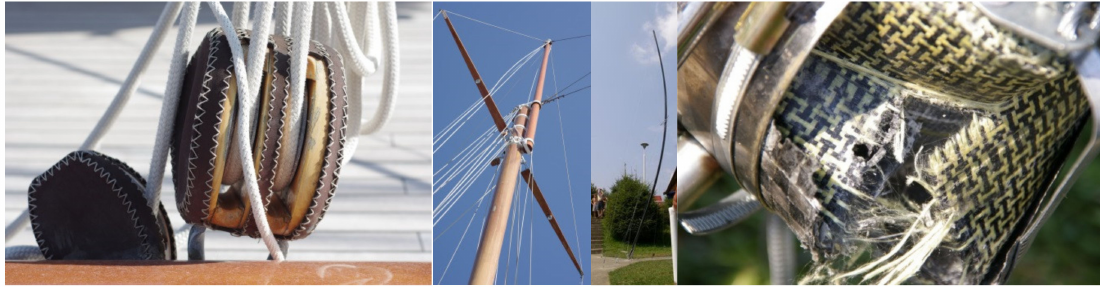
Figure 1. The classical wooden tackling versus the flexible composite mast is made from the polymer reinforced with aramid and carbon